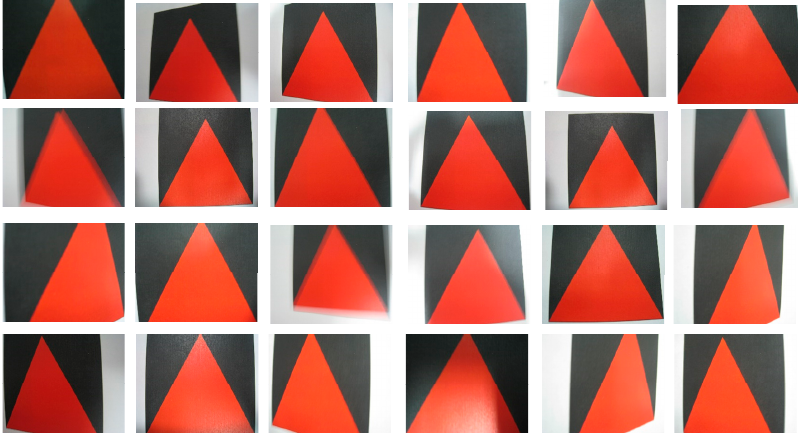
Figure 3. Some positive samples of acceleration sign.